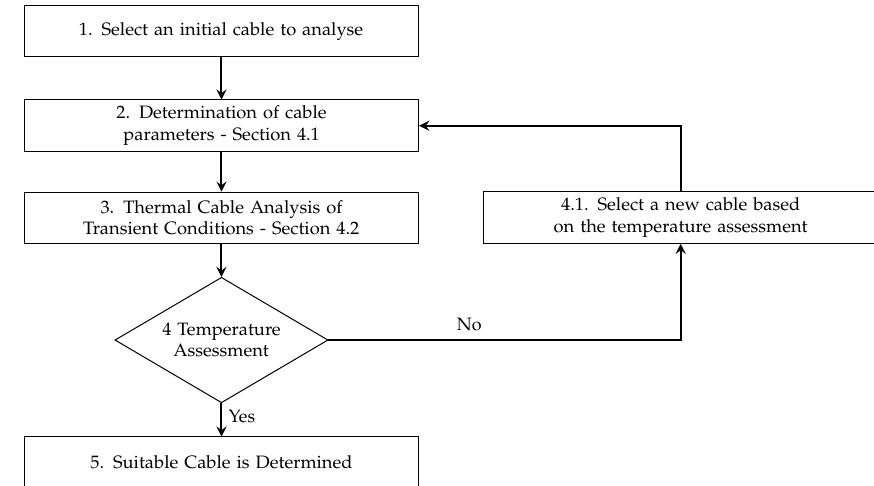
Figure 4. Flowchart of the iterative dynamic cable rating